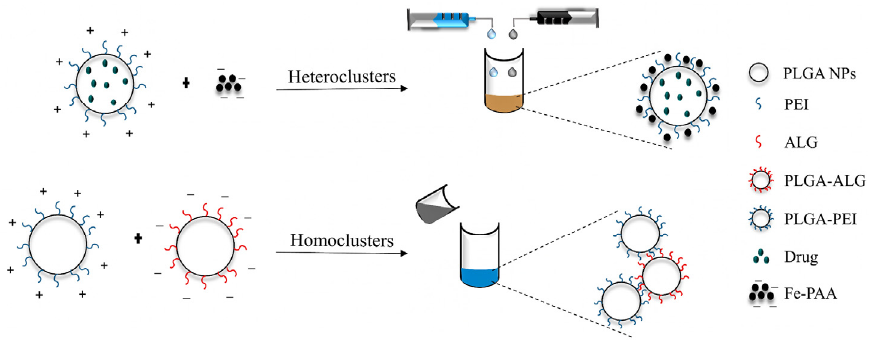
Figure 7. Schematic illustration of the multicomponent nanocluster system based on IO NPs and polymeric NPs. Heteroclusters assembly based on electrostatic interactions using one-shot and dropwise approach. Reprinted with permission from ref [261]; Zumaya et al., Eur. Polym. J. 133 (2020) 109795. Copyright (2020) Elsevier.